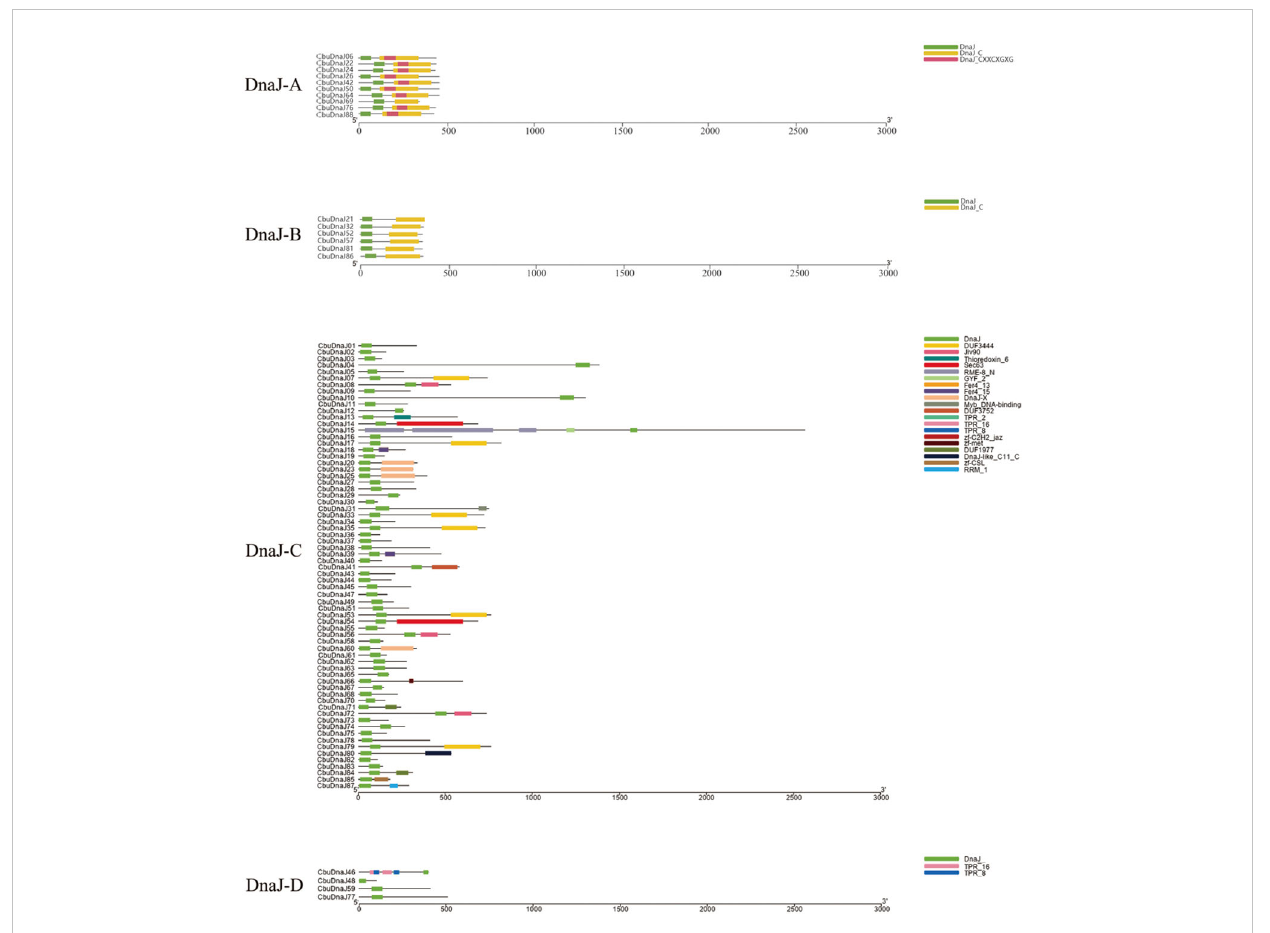
FIGURE 1 Schematic depiction of the characteristic domains of CbuDnaJs. CbuDnaJs were classi fi ed into four different